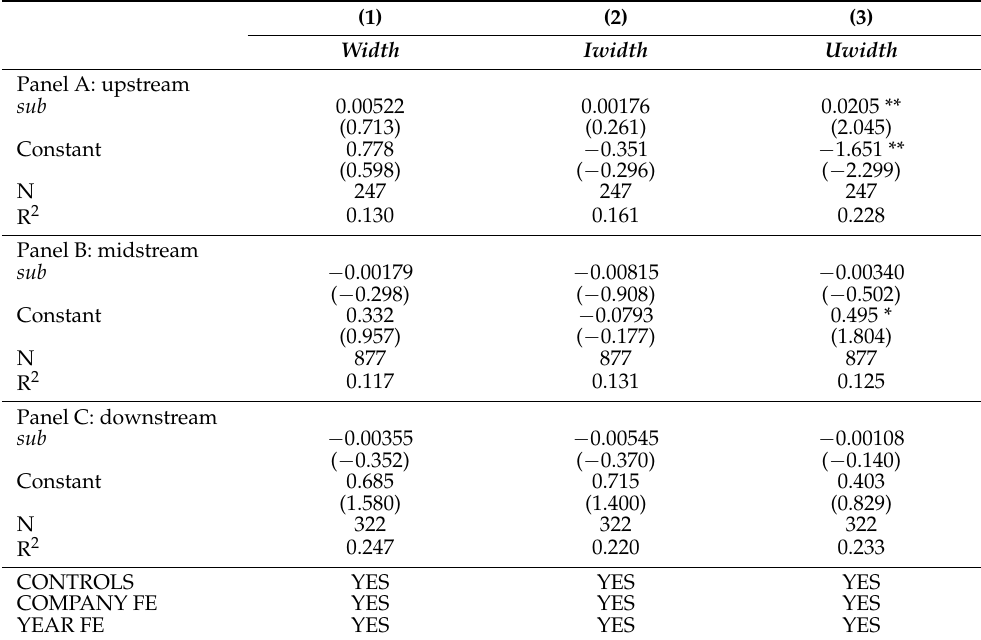
Table 13. Heterogeneity analysis: Industrial chain perspective (quality of technological